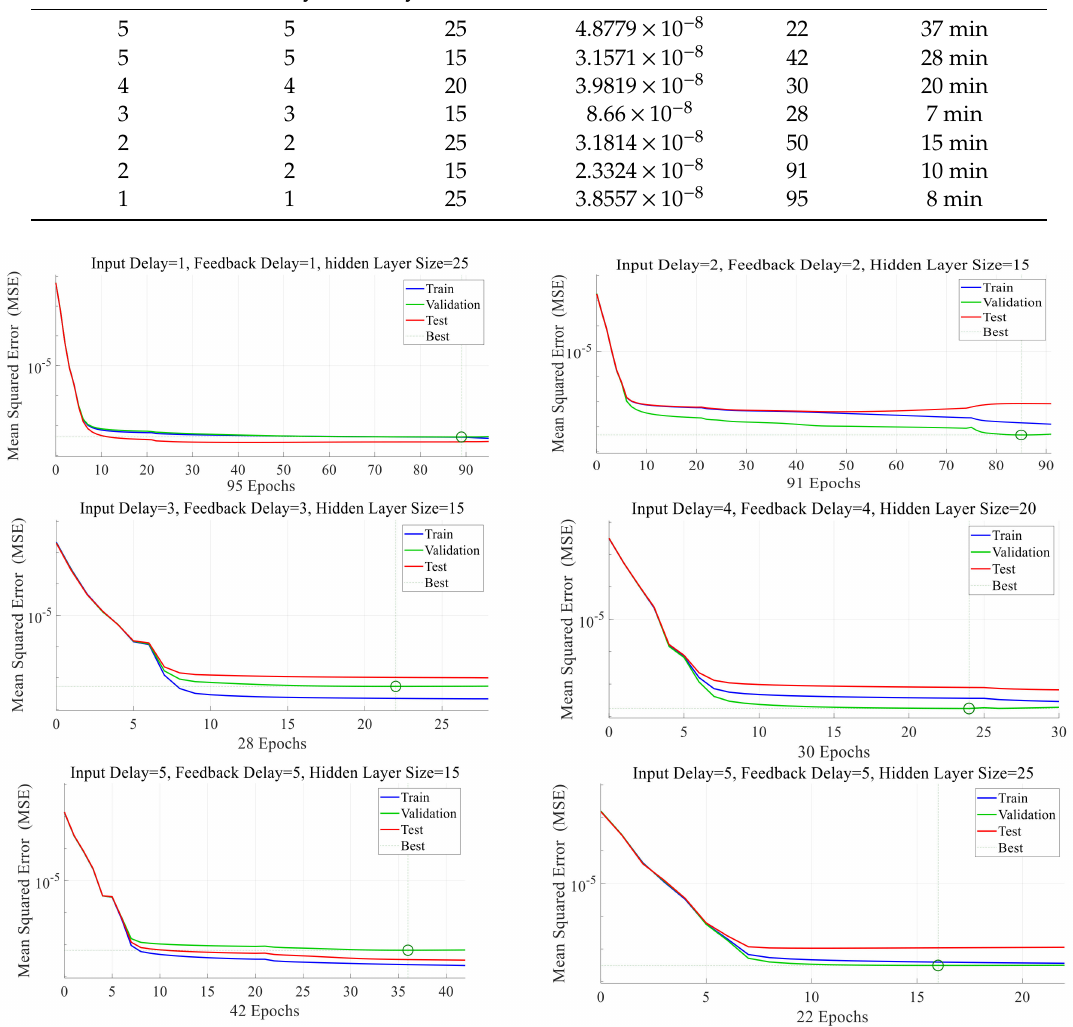
Figure 6. Various scenarios of RNARXNN training to improve the performance of the state